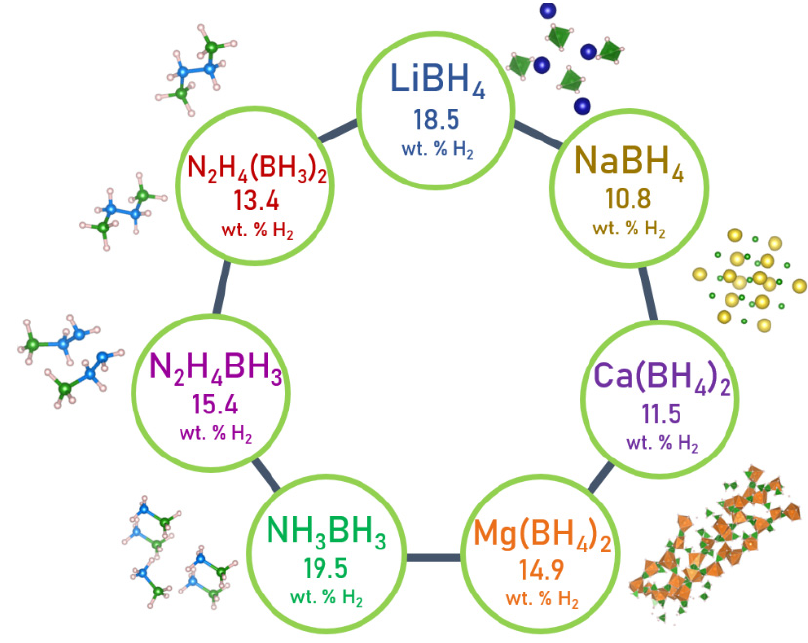
Figure 1. Selected B-based compounds and their gravimetric storage capacity.